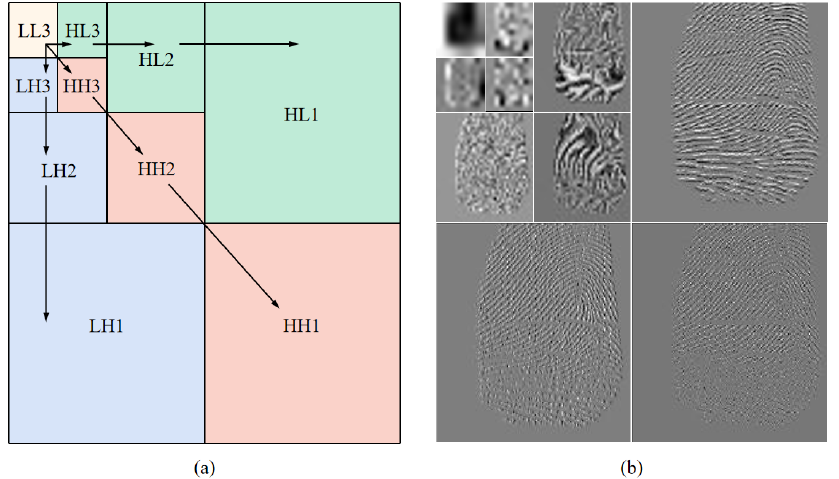
Figure 3. Discrete Wavelet Transform for the fingers’ gender classification. ( a ) Wavelet decomposes an image into sub-bands containing frequency and orientation information to represent valid